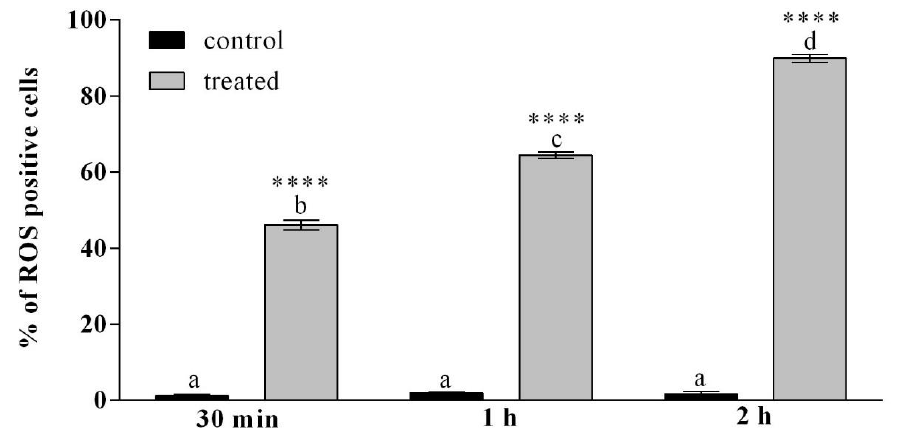
Figure 5. Percentage of haemocytes stained with H 2 DCFDA showing oxidative stress, after treatment with OPs deriving from 2 equivalent females at different times of exposure (30 min, 1 h and 2 h). Data are presented as mean ± SD ( n = 3). Statistical analysis was performed with one-way ANOVA and Bonferroni (for control vs. treatment analysis) and Tukey post-hoc test (for all sample analysis). Different letters indicate significant differences among all treatments ( p value < 0.0001), asterisks indicate significant differences between control and treated samples at the same experimental time ( p value < 0.0001).